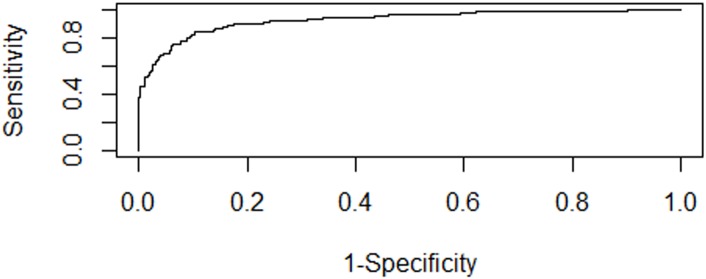
The ROC curve of logistic regression.